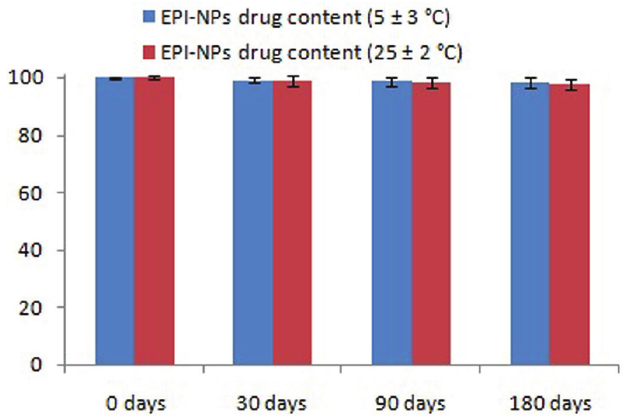
FIGURE 4 - Change in drug content into the EPI-NPs after storage at normal condition (5±3 °C) and accelerated condition (25±2